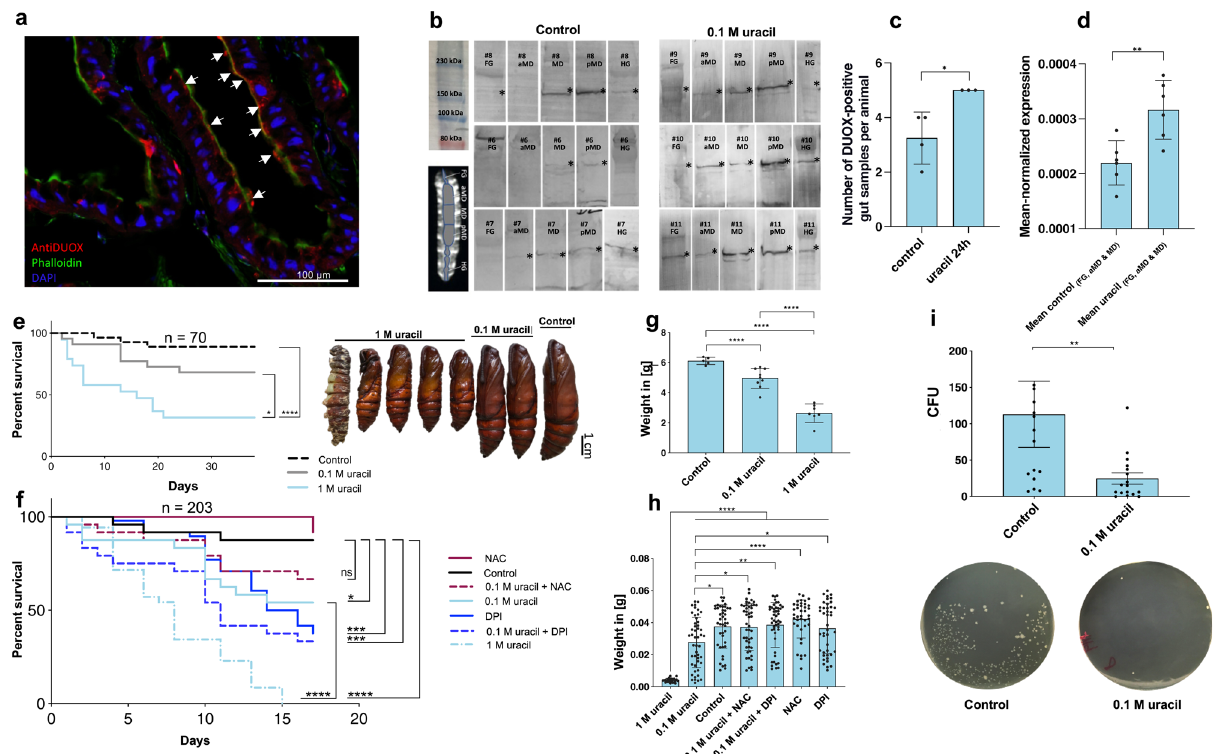
Fig. 7 | Location of M. sexta DUOX in the gut, its upregulation, and effect. a M. sexta DUOX is localized in the brush border of the midgut, experiments were repeated independently: n =8 with similar results. b , c Western blots con fi rming the upregulation of M.sexta DUOX after uracil treatment (24h).FG: foregut, aMD: anterior midgut, MD: medial midgut, pMD: posterior midgut, and HG: hindgut. *indicatesaproteinwiththerel.molecularweightof170kDa(DUOX).Moredetails abouttheWesternblotanalysisaregiveninFig.S22,two-tailedMannWhitneytest, P =0.0286, no adjustments, experiments were repeated independently: n =7 with similar results. See the source data fi le for a presentation of complete, uncropped blotsandgels. d Quantitativereal-timeRT-PCRanalysisof MsDUOX demonstrating theinductionof M.sextaDUOX afteruraciltreatment(8h)intheanteriordigestive